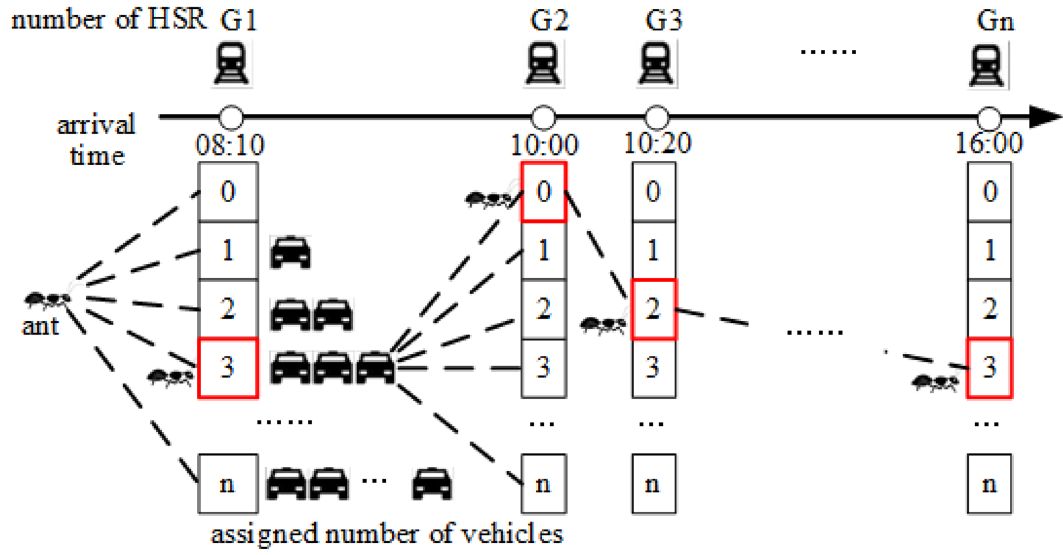
Figure 1. Schematic diagram of node selection in the first layer of improved ACO algorithm.